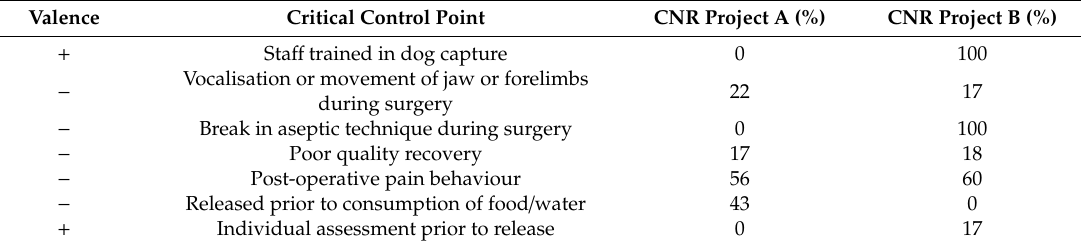
Table 5. Relative prevalence of selected CCPs as observed at the two CNR projects ‘A’ and